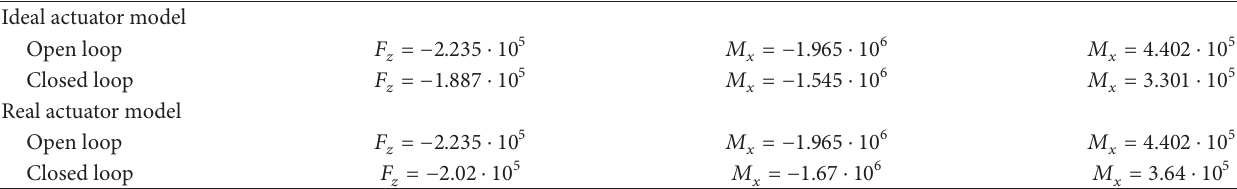
Table 2: Open and closed loop responses: ideal and real actuators.